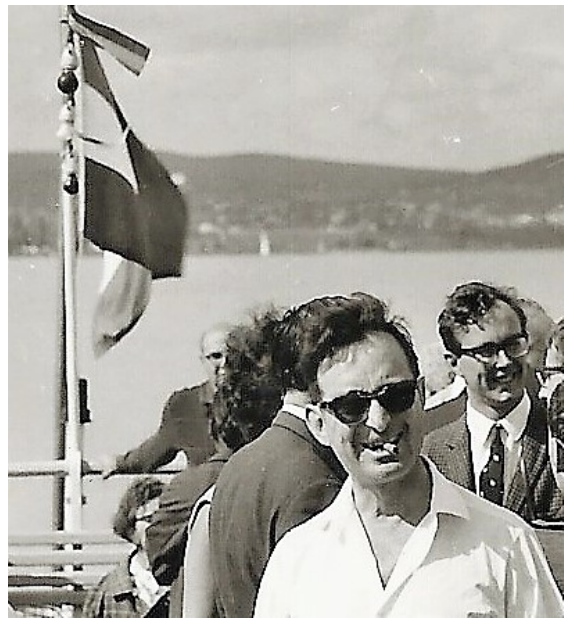
Figure 5: Frank Harary and Robin Wilson, Balatonf¨ured, Hungary, 1969; photograph by Bjarne